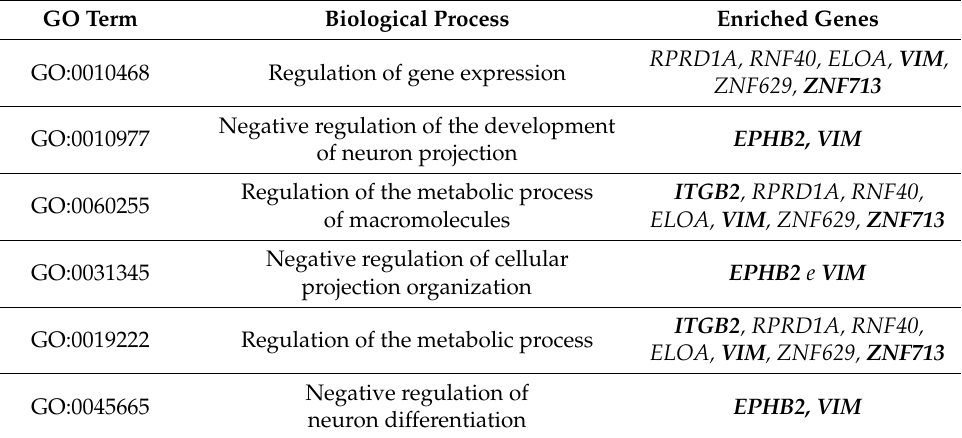
Table 10. Biological processes enriched with genes harboring single nucleotide polymorphisms (SNPs) in the umbilical hernia group.